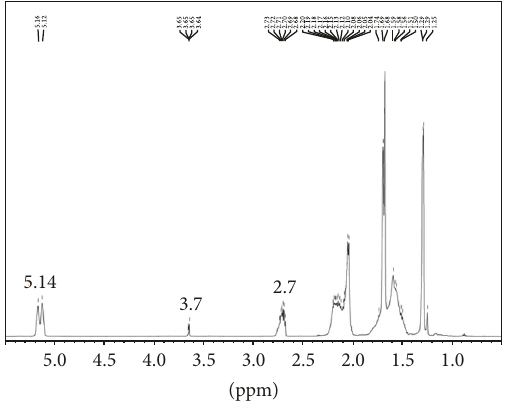
Figure 2: 1 H-NMR spectrum of ENR